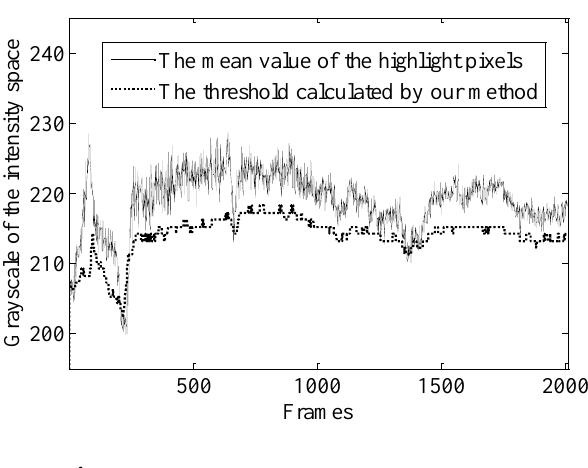
Figure 3. Tendency of the adaptive